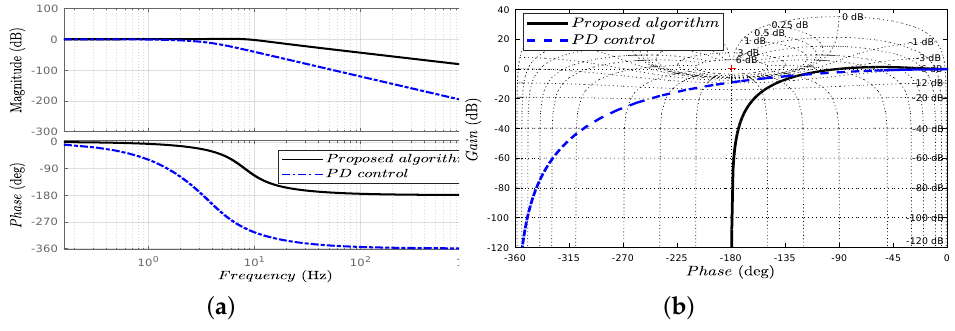
Figure 13. The Bode diagram and the Nichols chart of the control system. ( a ) Frequency response for different control scheme; ( b ) nichols chart for different control schemes. For verifying the open-loop stability, the Bode diagram and Nichols chart are presented with the PD control algorithm and our proposed algorithm. Although both algorithms are stable in the open-loop, the bandwidth of our proposed algorithm is more extensive and hence responds more quickly. In addition, the control system with the PD controller may lose information of the normal high-frequency motion.